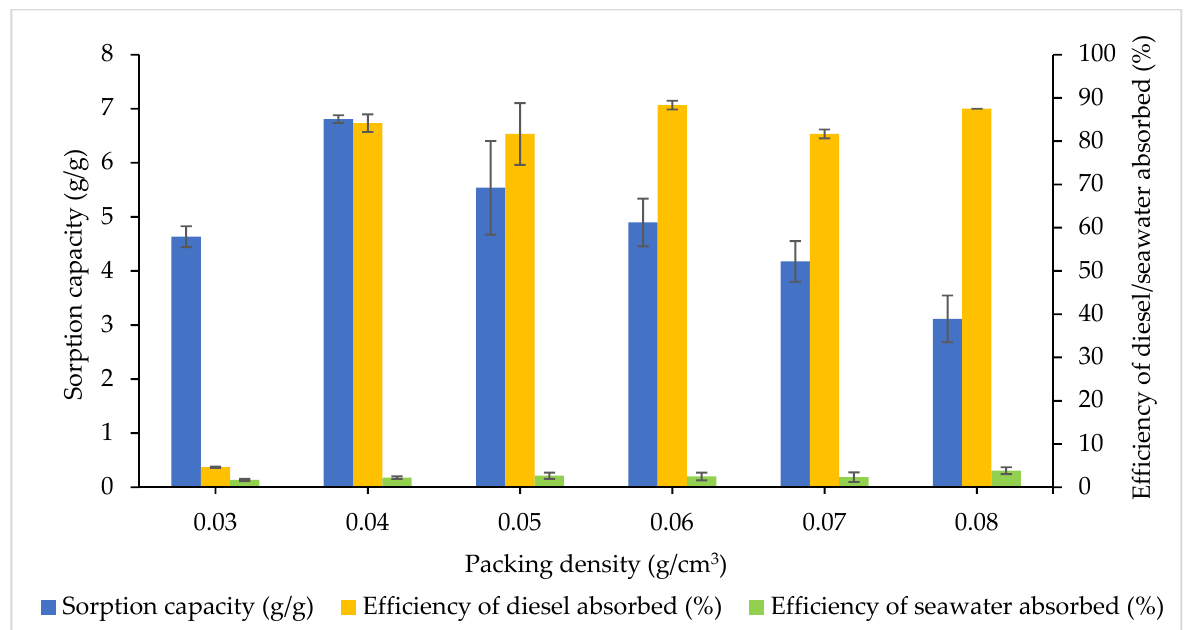
Figure 7. Effects of the packing density of CP. The error bars represent the mean ± SEM for three replicates ( n = 3).